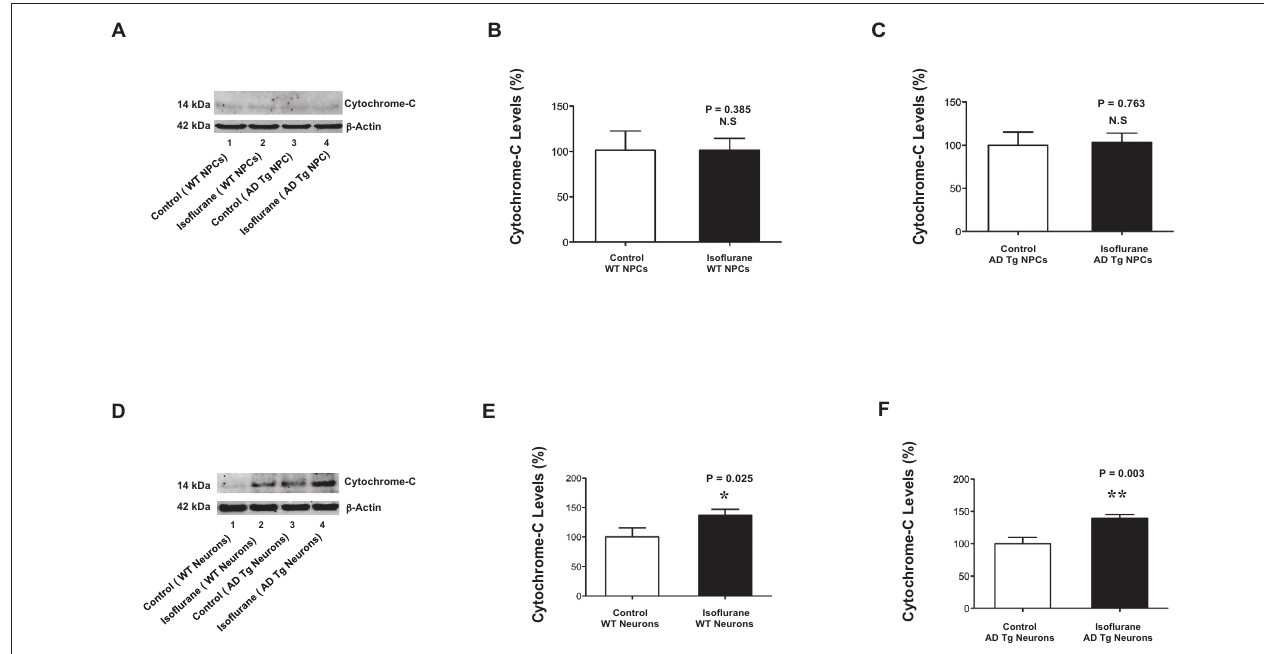
the cytosol cytochrome c levels following the treatment of isoflurane (lane 2) as compared to that following the control condition (lane 1) in the WT mice neurons. There is a visible increase in the cytosol cytochrome c levels following the treatment of isoflurane (lane 4) as compared to that following the control condition (lane 3) in the AD Tg mice neurons. (E) The quantification of the Western blot shows that the isoflurane treatment (black bar) increases cytosol cytochrome c levels as compared to control condition (white bar) in the WT mice neurons. (F) The quantification of the Western blot shows that the isoflurane treatment (black bar) increases cytosol cytochrome c levels as compared to the control condition (white bar) in the AD Tg mice neurons. NPCs, neural progenitor cells; AD, Alzheimer’s disease; Tg, transgenic; WT,